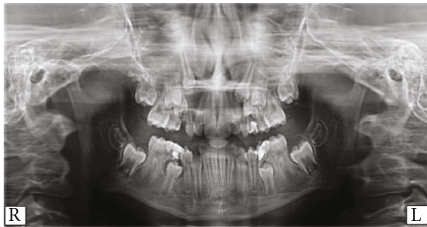
Figure 3: Older orthopantomogram (OPG) showing the absence of any radiolucent lesion at the mandibular left side (second premolar